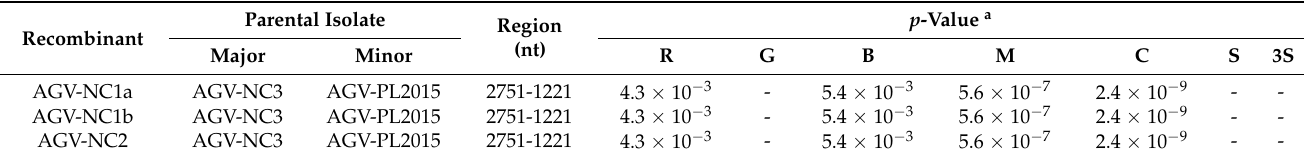
Table 1. Recombination events among the five apple geminivirus isolates predicted by